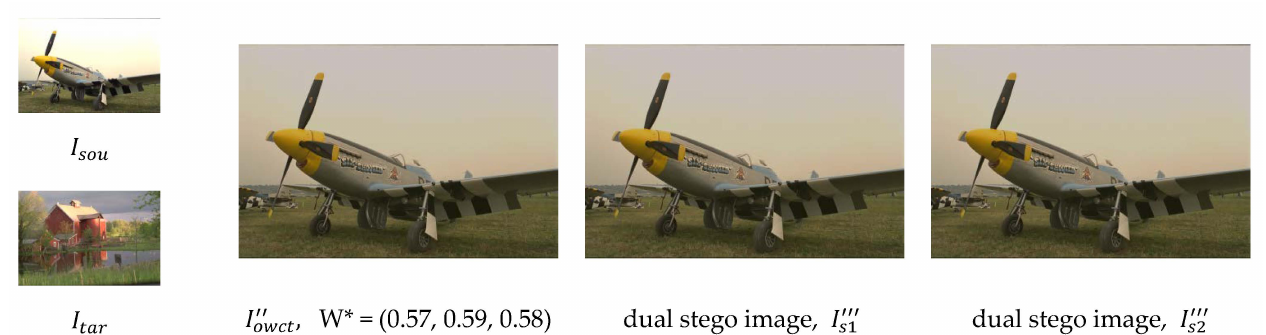
Figure 8. The visual inspection of the test image “Kodim07”.